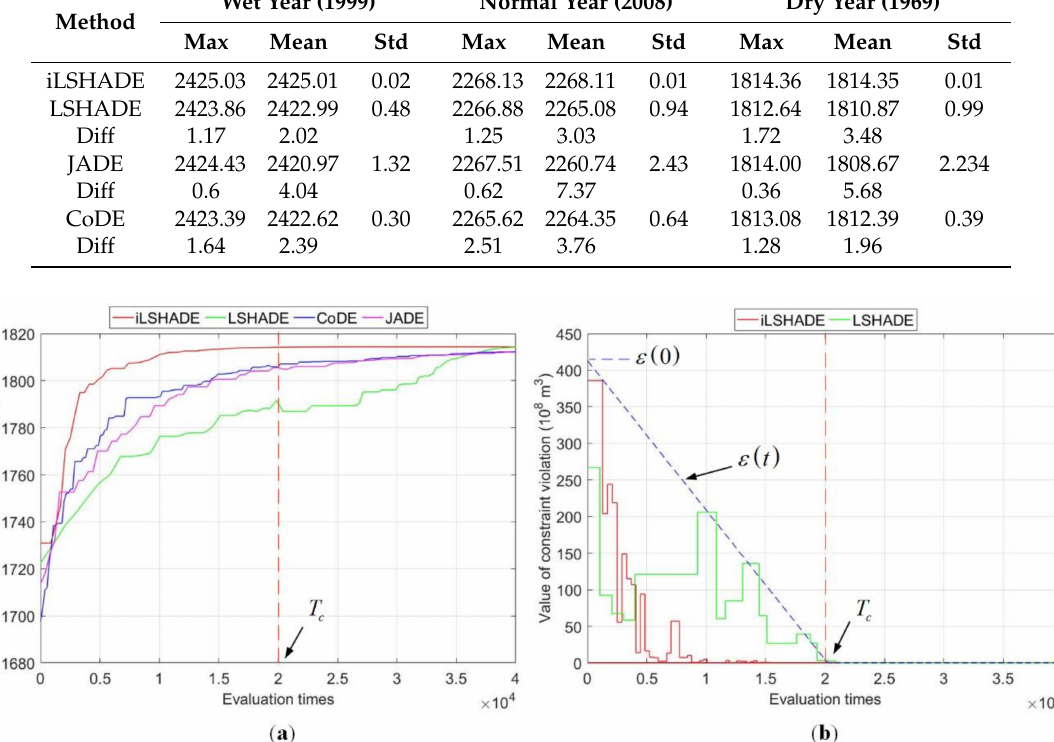
Figure 6. Convergence process of different